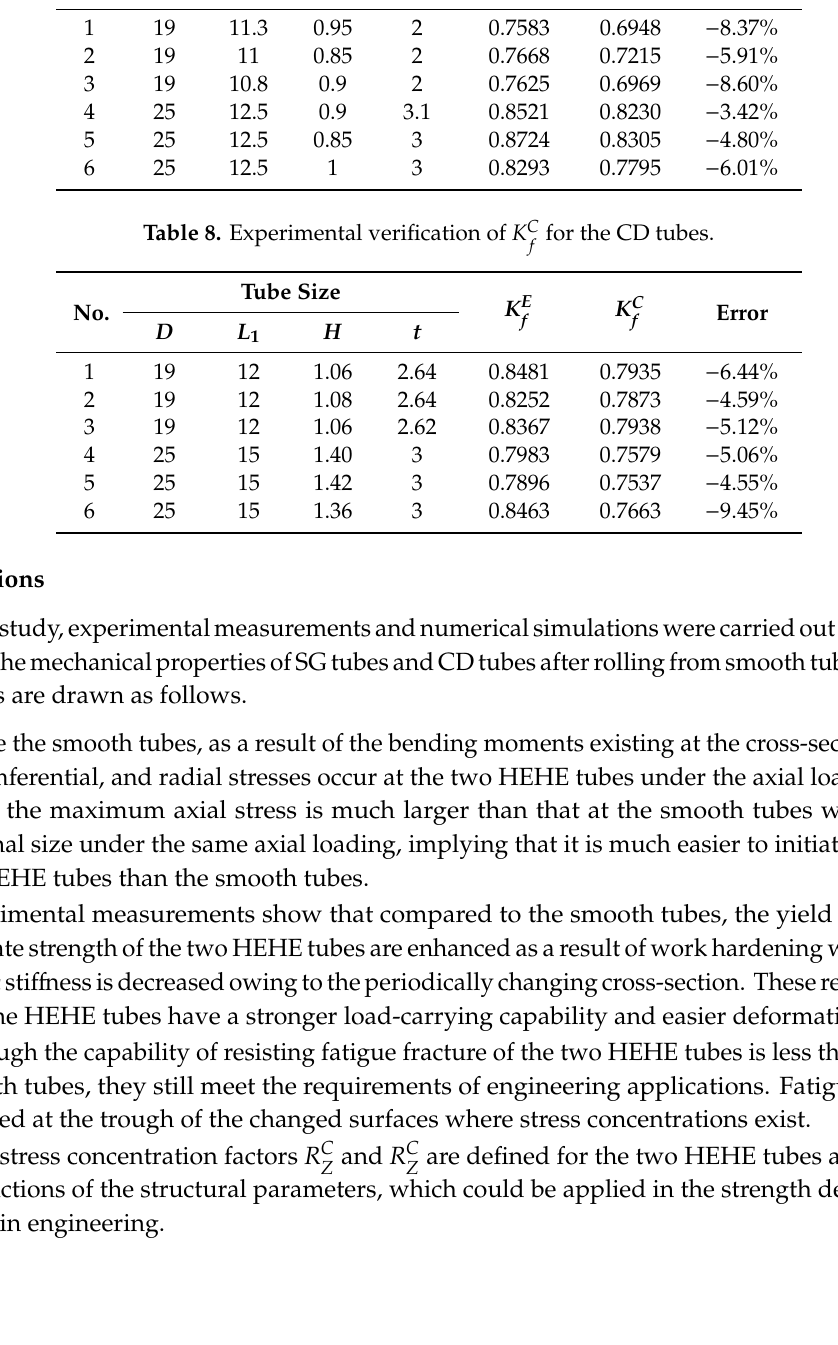
Table 7. Experimental verification of K S